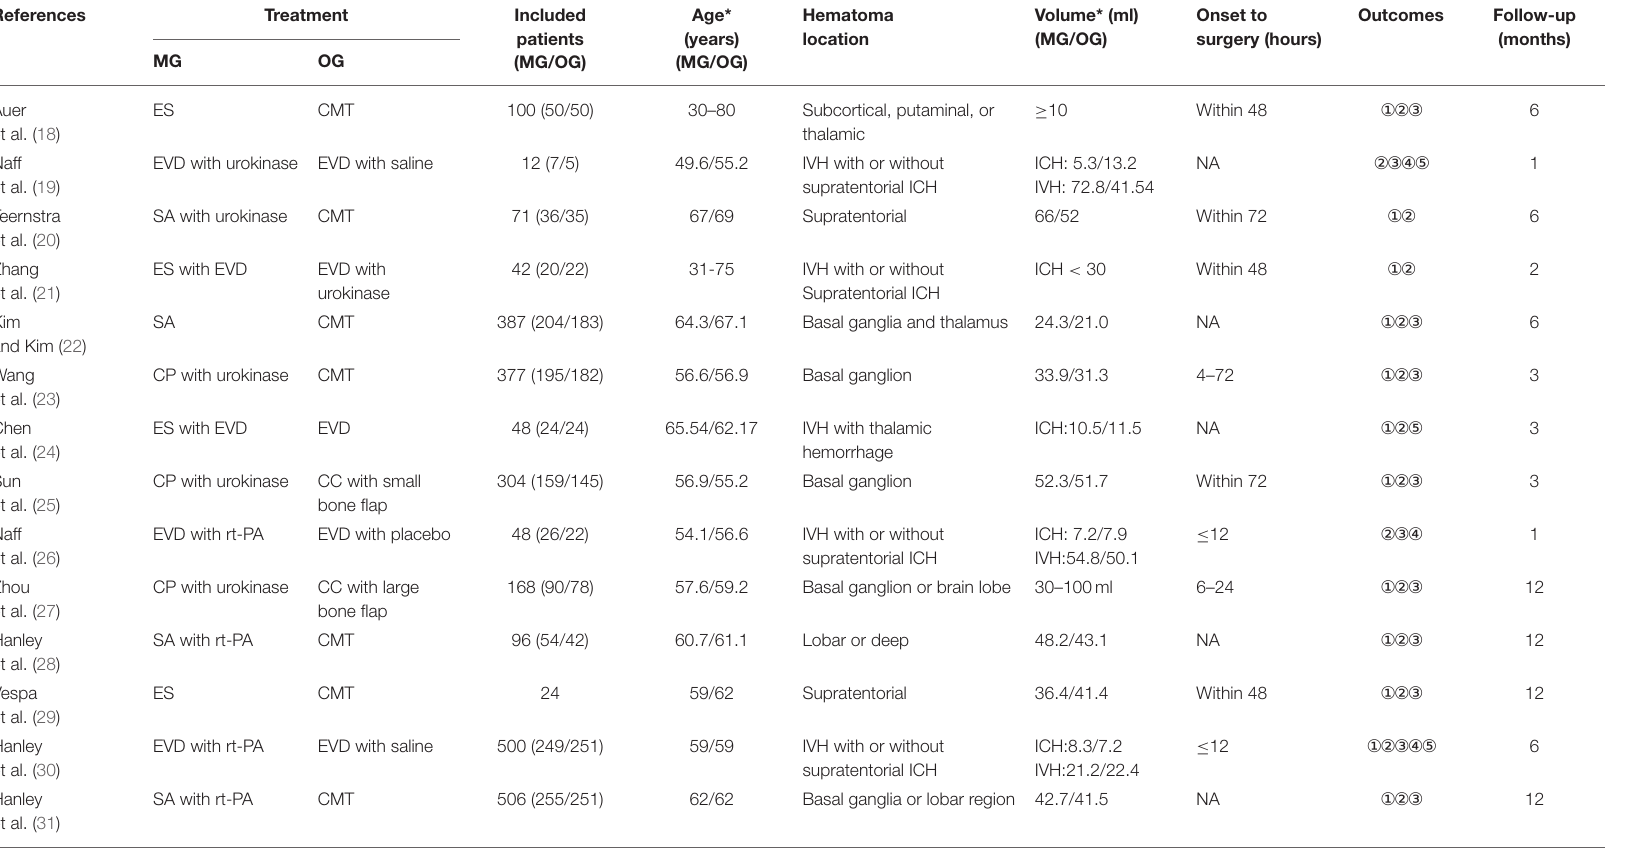
TABLE 1 | Randomized controlled trials of MIS for ICH and